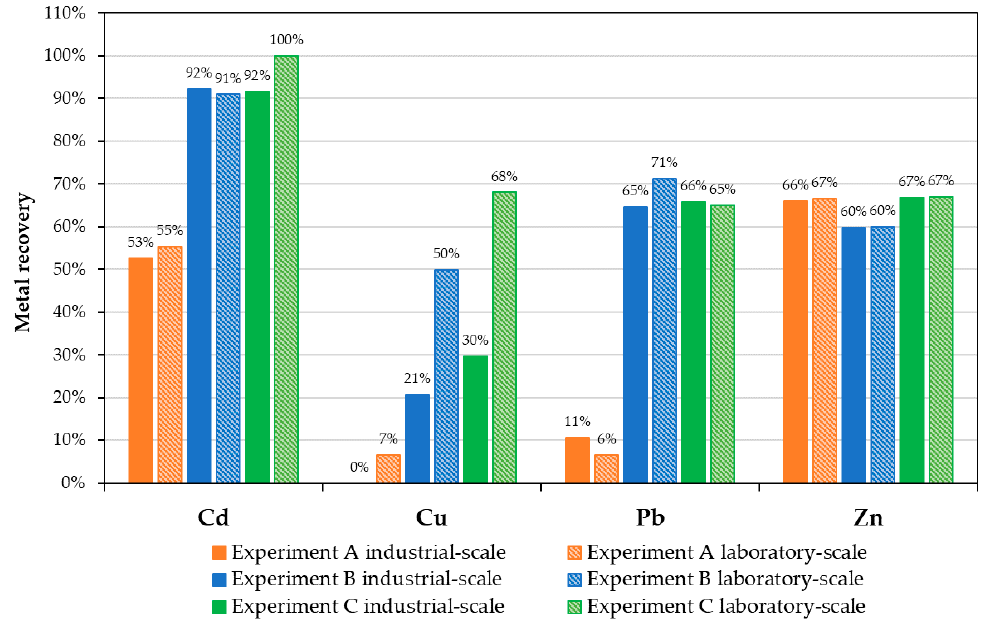
Figure 4. Metal recoveries of the FLUWA process of the three industrial-scale experiments and the corresponding laboratory-scale experiments.